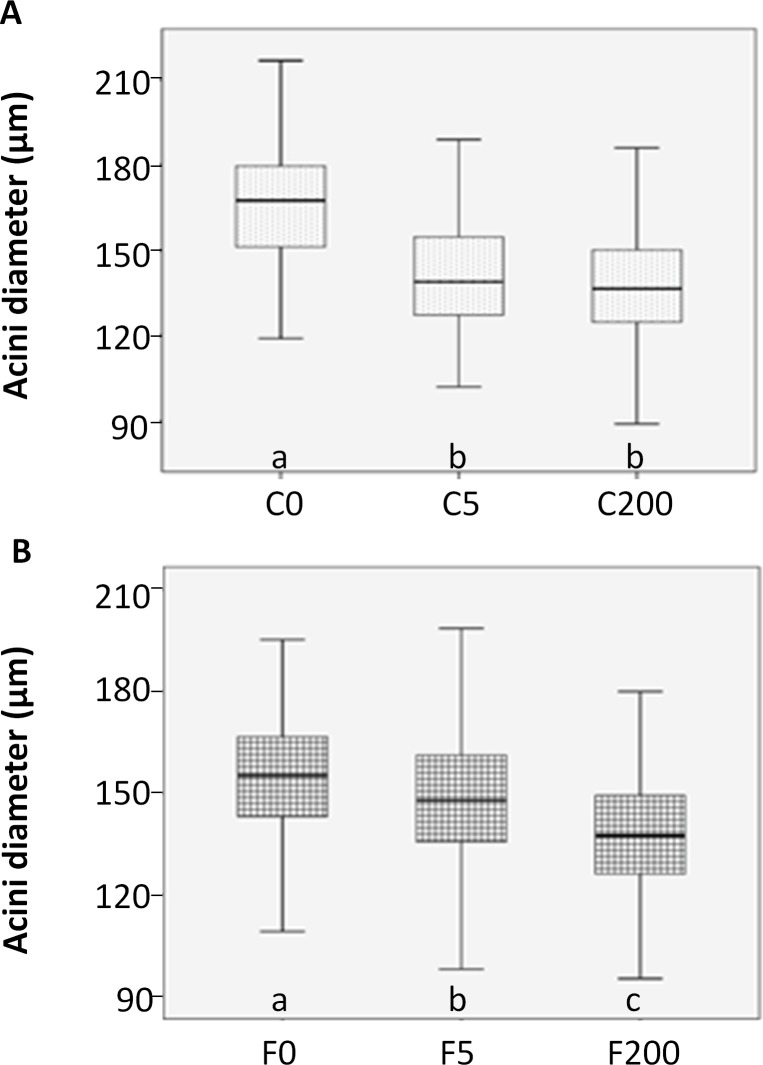
HPG acini diameters.A boxplot from the acini diameter (in micrometer) of the different experimental groups. Different letters below the bars denote significant differences between the groups, P<0.001 for each experimental design. C0: cage experiment not treated; C5: cage experiment treated with 5 ppb; C200: cage experiment treated with 200 ppb; F0: field experiment not treated; F5: field experiment treated with 5 ppb; F200: field experiment treated with 200 ppb.